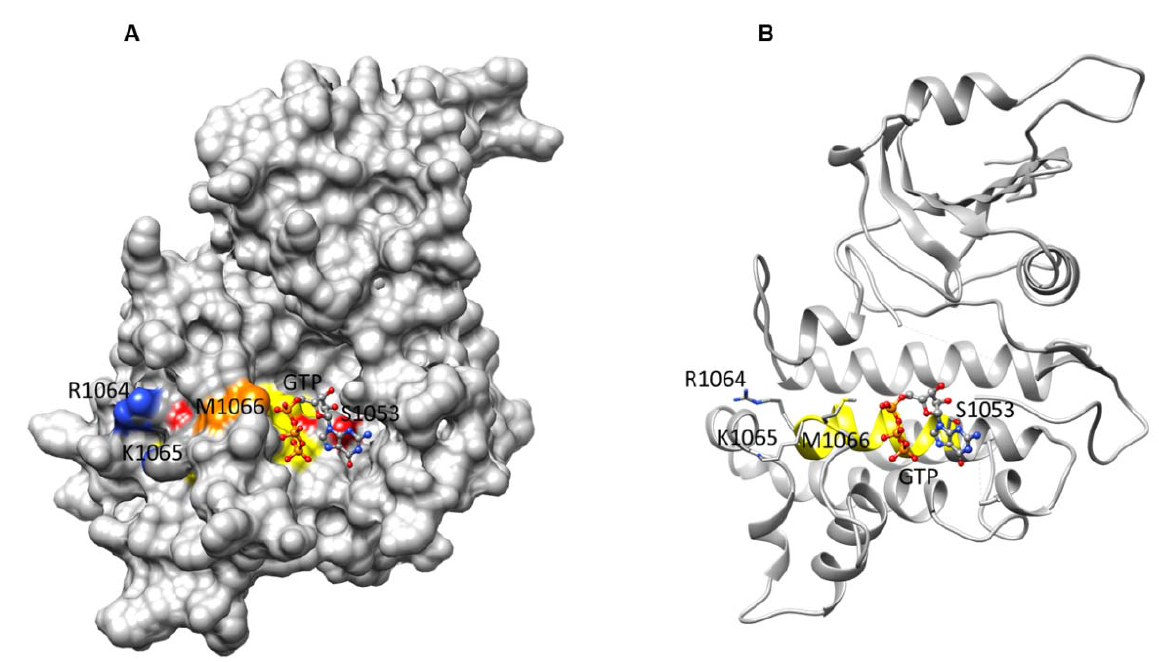
Figure 4. Docking of GTP at the GC center of BdPepR2 and interaction of GTP with key residues at catalytic center (yellow) is shown as ( A ) surface and ( B ) ribbon models, respectively. Functional residues at positions 1 (S1053, red) and 14 (M1066, orange) of the motif and neighboring R1064 (position 12) and K1065 (position 13) facing away from the GC center are shown.